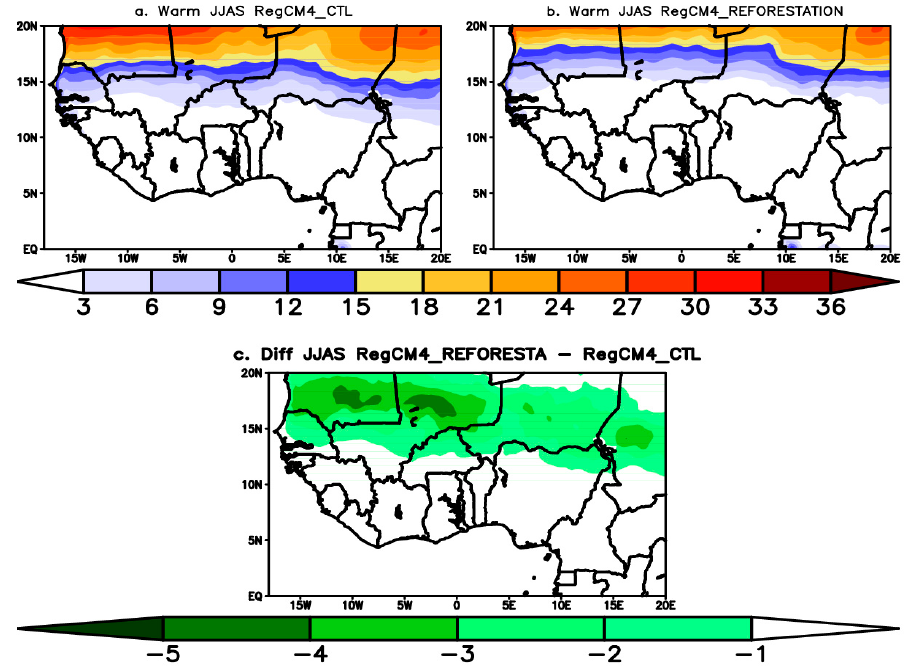
Figure 5. Number (expressed in days) of extreme warm days during the JJAS period averaged from 1990 to 2009 over West Africa for: ( a ) RegCM4_CTL; ( b ) RegCM4_REFORESTATION and ( c ) RegCM4_REFORESTATION—RegCM4_CTL.